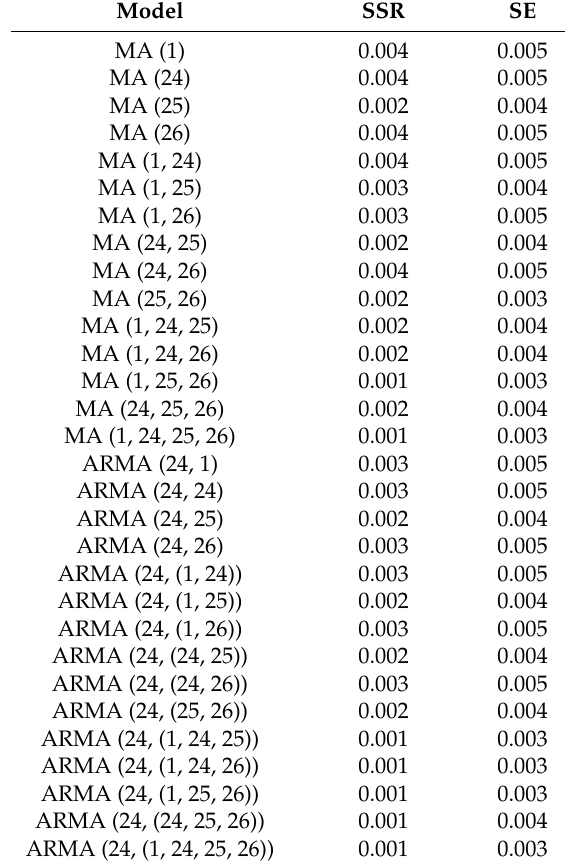
Table 10. SSR and SE of ARMA (p, q).